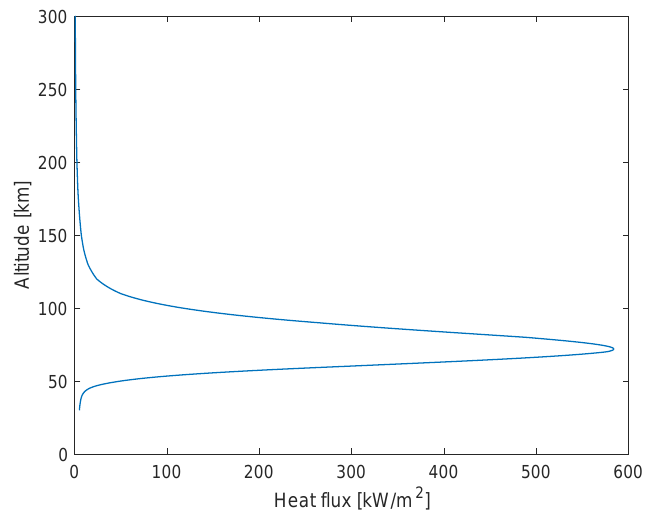
Figure 3. Variation of the heat flux on the capsule during re-entry. The maximum value, reached at the altitude H = 71.94 km, is 583.91 kW/m 2